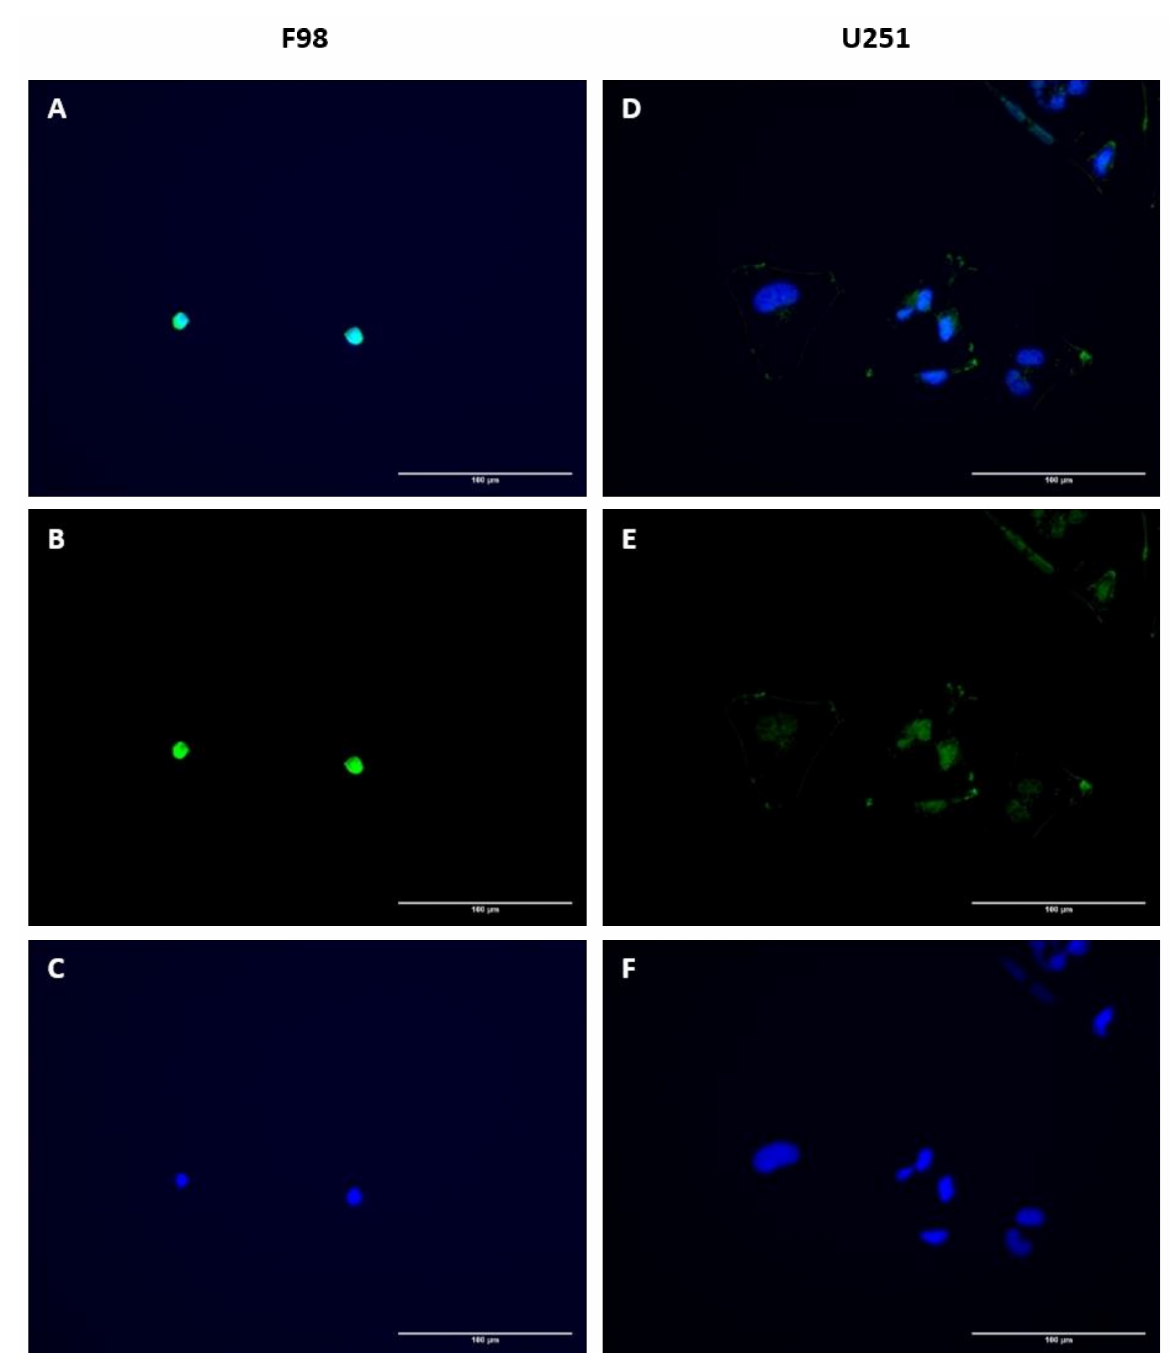
Figure 5. Immunofluorescent staining of HDAC1 enzyme. Representative images of the HDAC1 staining in ( A – C ) F98 cells and ( D – F ) U251 cells. ( A , D ) pictures displays the merged channels, ( B , E ) the green channel only and ( C , F ) the blue channel only. (Scale bar: 100 µ m, magnification × 40, green channel: HDAC1 staining, blue channel: nuclei